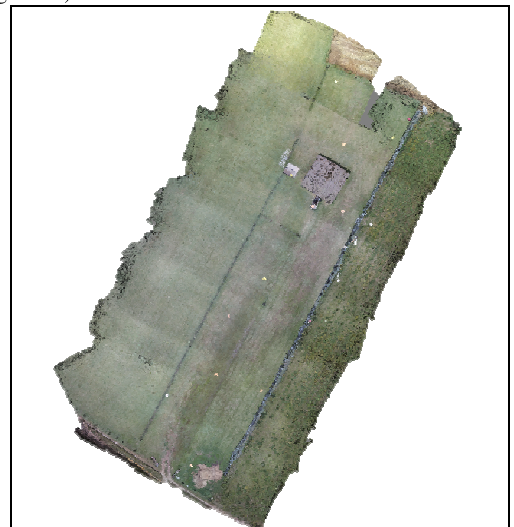
Figure 12. The georeferenced dense point cloud of the flight field, obtained by the image processing by the tool Agisoft Photoscan